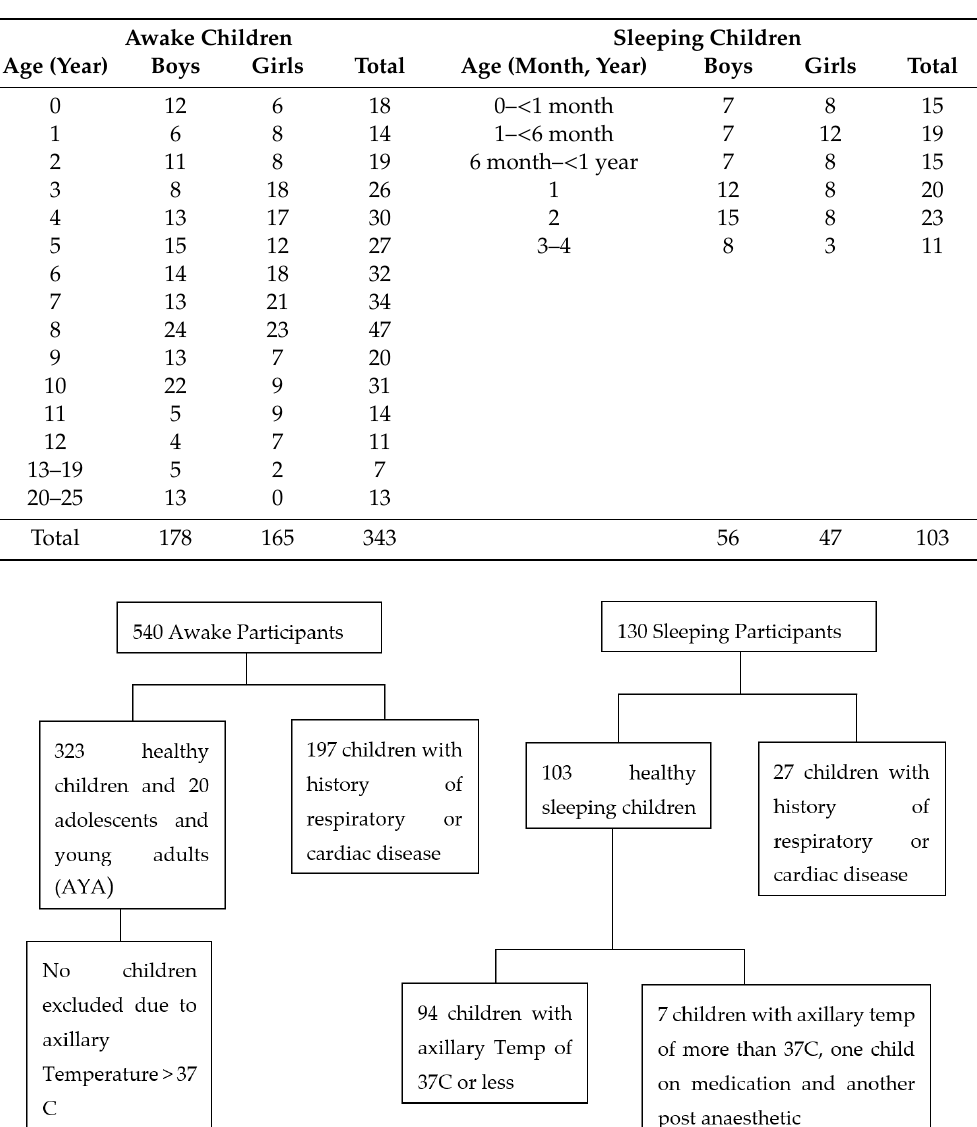
Table 2. Age and gender of healthy children in study.